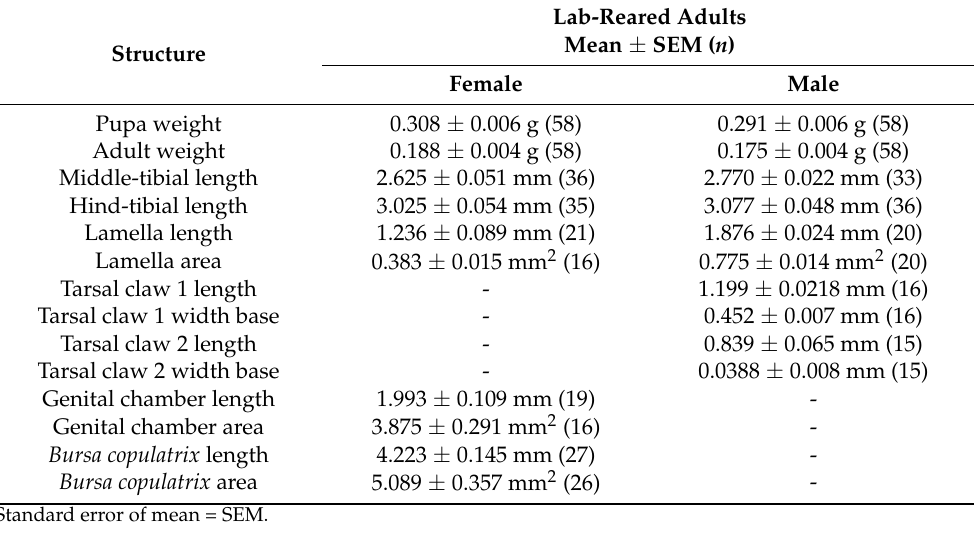
Table 1. Measurement of different body parts of Cyclocephala barrerai adults.